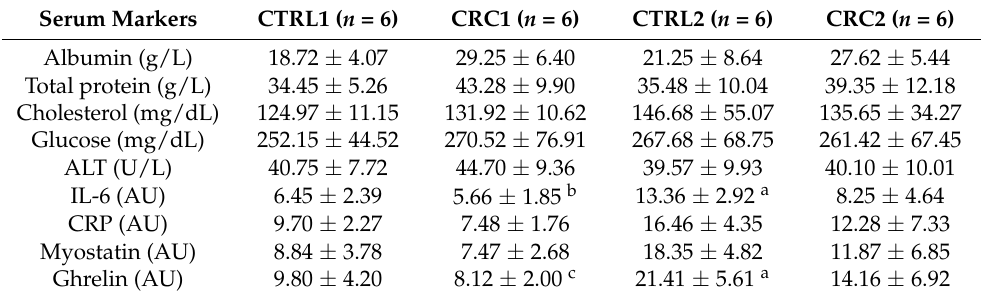
Table 3. Serum levels of albumin, total protein, cholesterol, glucose, ALT, IL-6, CRP, myostatin, and ghrelin. Data are presented as mean ±